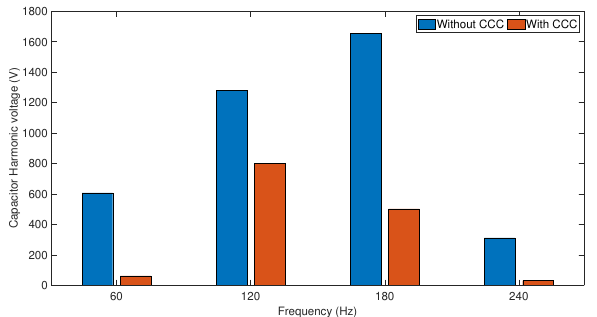
Figure 5. FFT analysis of the total submodule capacitor